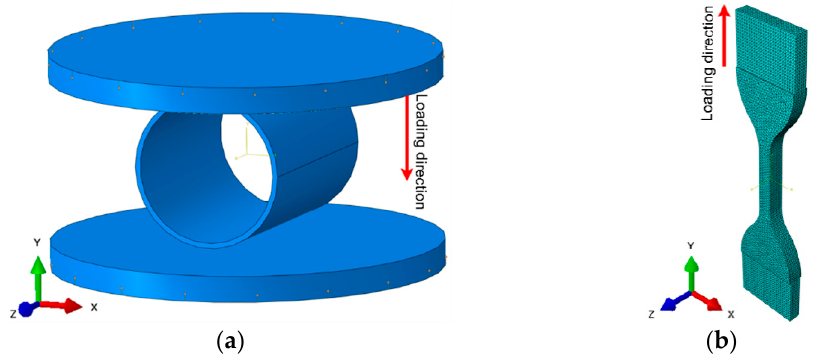
Figure 4. Examples of finite-element simulations in the ABAQUS code: ( a ) compression of a pipe; ( b ) extension of a specimen.